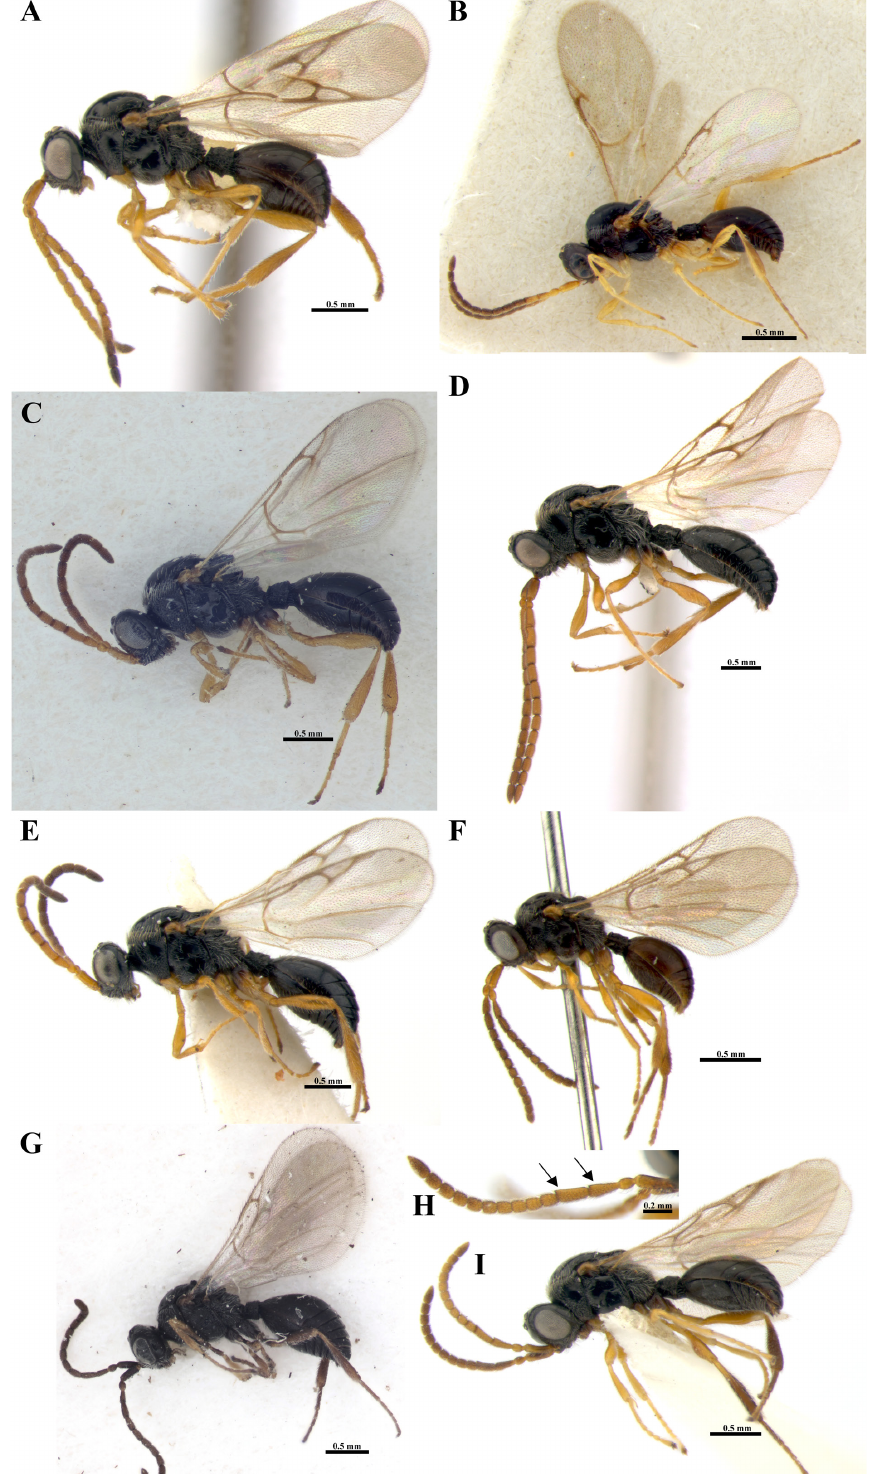
Fig. 2. Ismarus spp., ♂♂. (A–G, I. Habitus; H. Antennae). A . I . apicalis Kolyada &